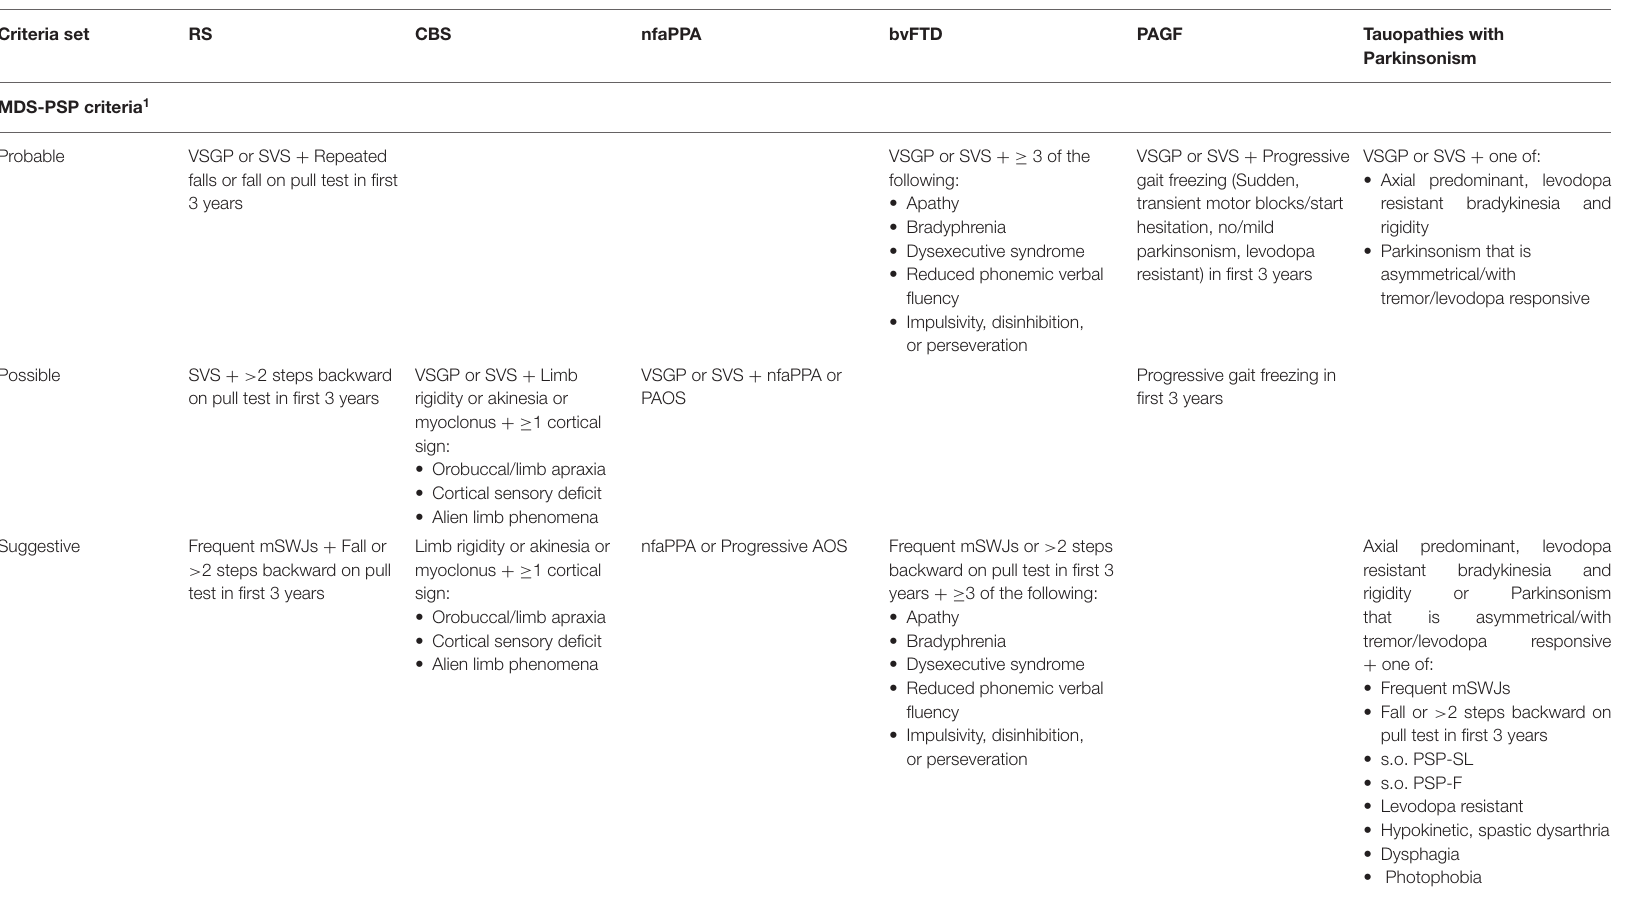
TABLE 2 | Standardized clinical diagnostic criteria of phenotypes related to primary tauopathies based on Movement Disorders Society Progressive Supranuclear Palsy (MDS-PSP) criteria, (91), Armstrong corticobasal degeneration (CBD) (24) criteria, Gorno-Tempini Primary Progressive Aphasia (PPA) criteria (92), and Rascovsky behavioral variant Frontotemporal Dementia (bvFTD) criteria